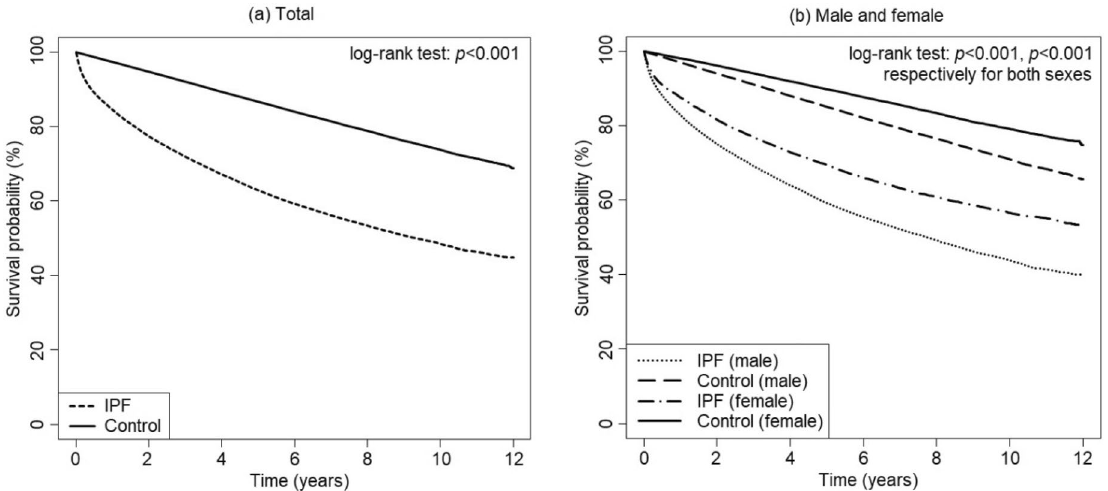
Figure 2. Survival rate of patients with idiopathic pulmonary fibrosis (IPF) compared to control group by Kaplan–Meier curve analysis.